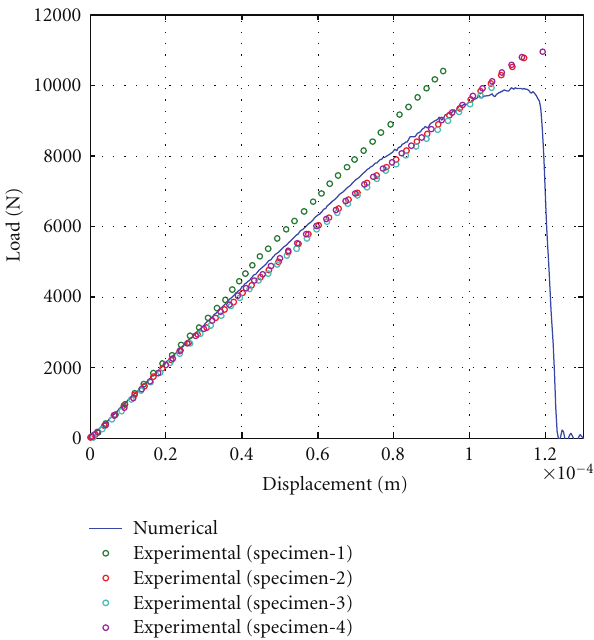
Figure 20: Comparison between numerical predictions and experimental results for the fibre compression tests.